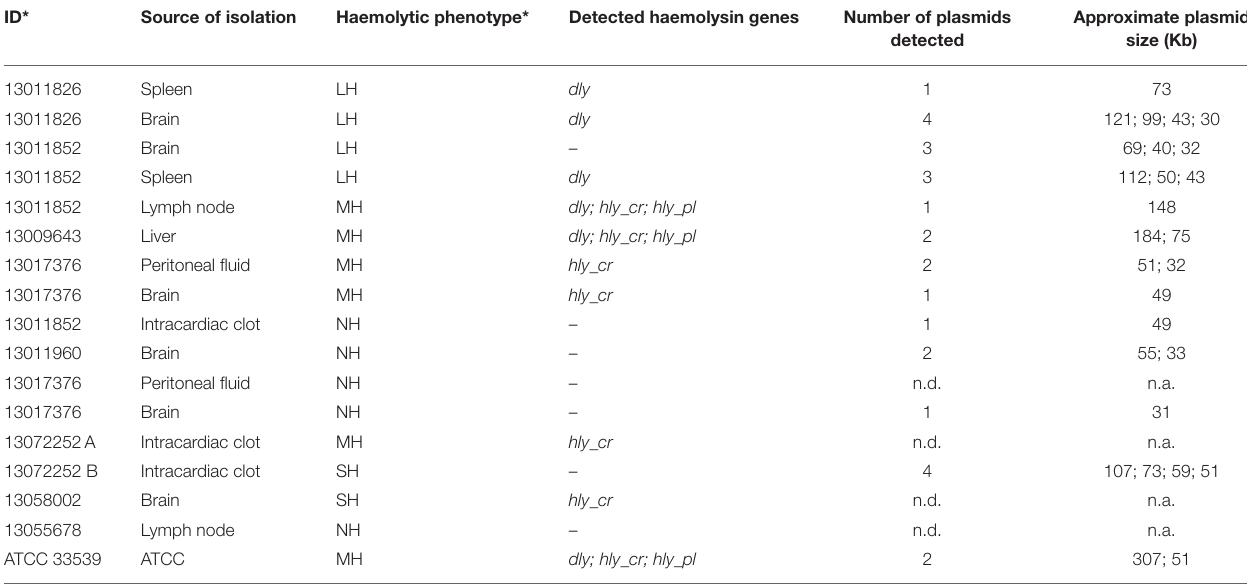
TABLE 1 | Description of the 17 isolates selected for plasmid detection and subjected to S1 nuclease-PFGE.